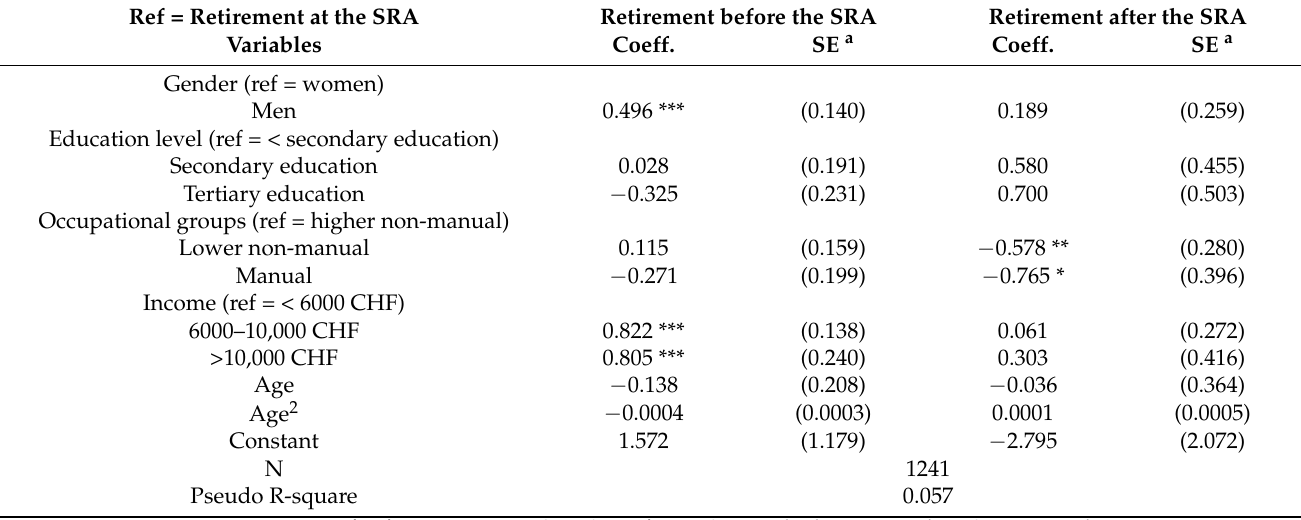
Table 2. Determinants of retiring after the statutory retirement age